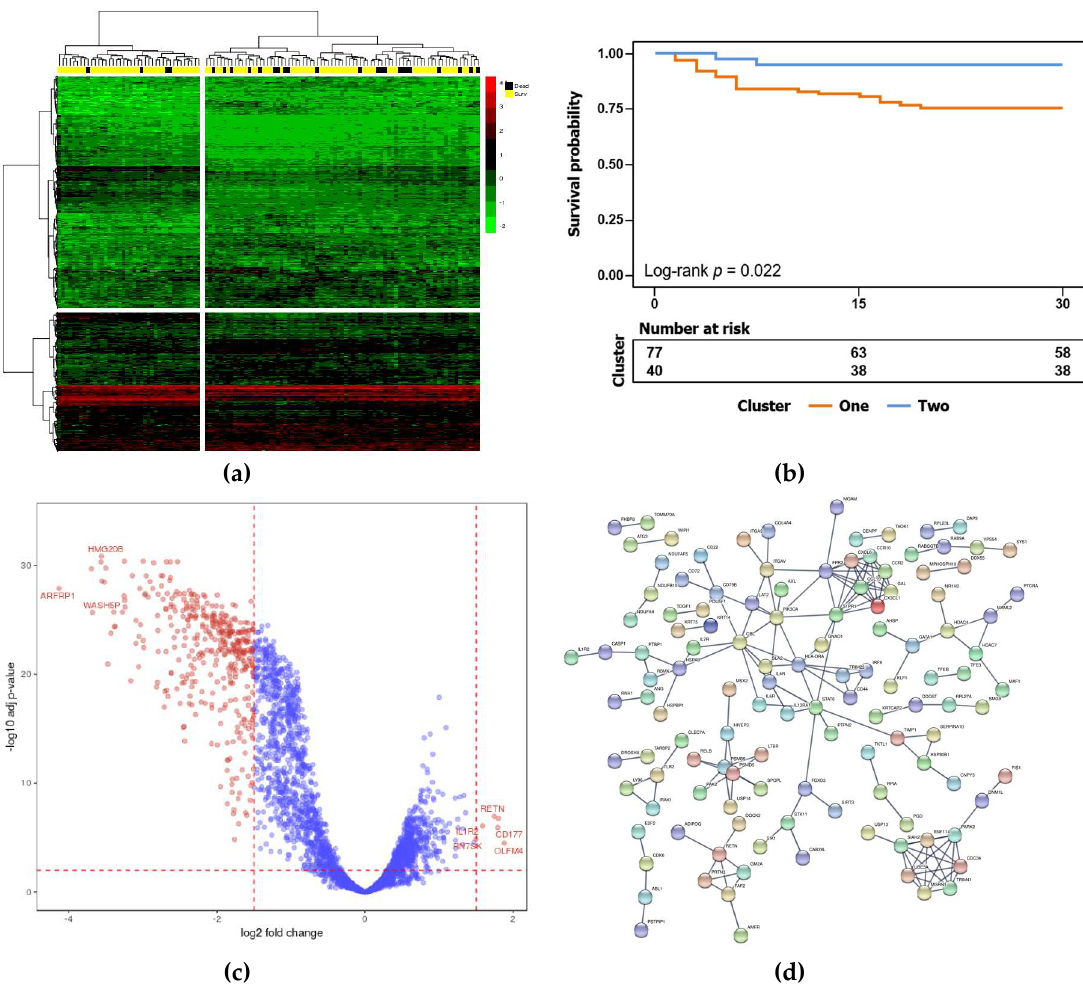
Figure 1. Identification of biomarker genes from gene expression data. ( a ) Heat map plot of genes of interest. Rows represent the gene expression value and columns represent the samples. The scale bar represents the intensity of expression of transcripts, with red indicating overexpressed transcripts and green representing underexpressed transcripts. The top bar indicates surviving (yellow) and non-surviving patients (black); ( b ) Kaplan–Meier plot showing survival probability of two groups of patients clustered by risk mortality. The numbers below the graph indicate the number of patients at risk of death in each group; ( c ) volcano plot of the differentially expressed genes, with red coloring for fold changes >1.5 and p -value < 0.01; ( d ) protein–protein interaction network of differentially expressed genes.